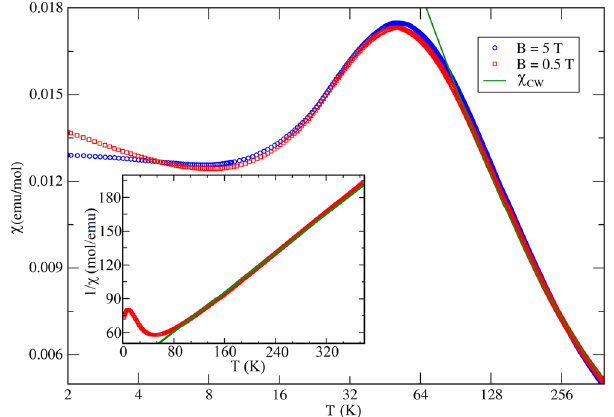
Figure 3. Magnetic susceptibility χ ( T ) for KCu 5 O 2 (SeO 3 ) 2 Cl 3 obtained under different values of the external magnetic field in the field-cooling regime. The inset shows the Curie-Weiss approximation in the 100–380 K temperature range with the parameters θ = 60 K and C = 2.3 emu K/mol, as denoted by the green